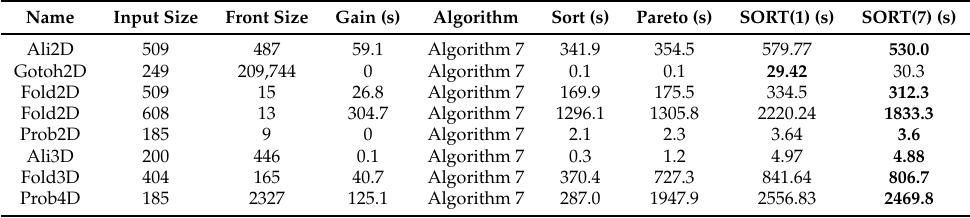
Table 4. Summary of computation times and metadata of test cases. Left: Isolated sorting time gains over Algorithm 1. Input length and the final size of the resulting Pareto front are given. Input size denotes the number of characters in the input sequence. Middle: Total runtimes of sorting phase and full Pareto operators, including sorting for the best algorithm. Right: SORT(1) and SORT(7) show the full running times of the basic sorted (Algorithm 1, pf sort ) and the specialized sorted (Algorithm 7, pf sort )